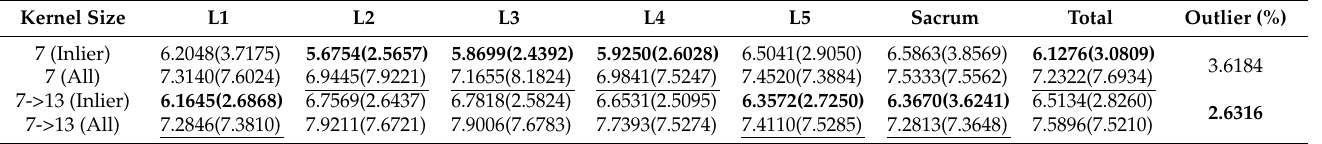
Table 2. Comparison of center distance error of Pose-Net according to kernel size change. The value having the lowest distance error for each column in (Inlier) is marked in bold and underlined for (All). Kernel Size L1